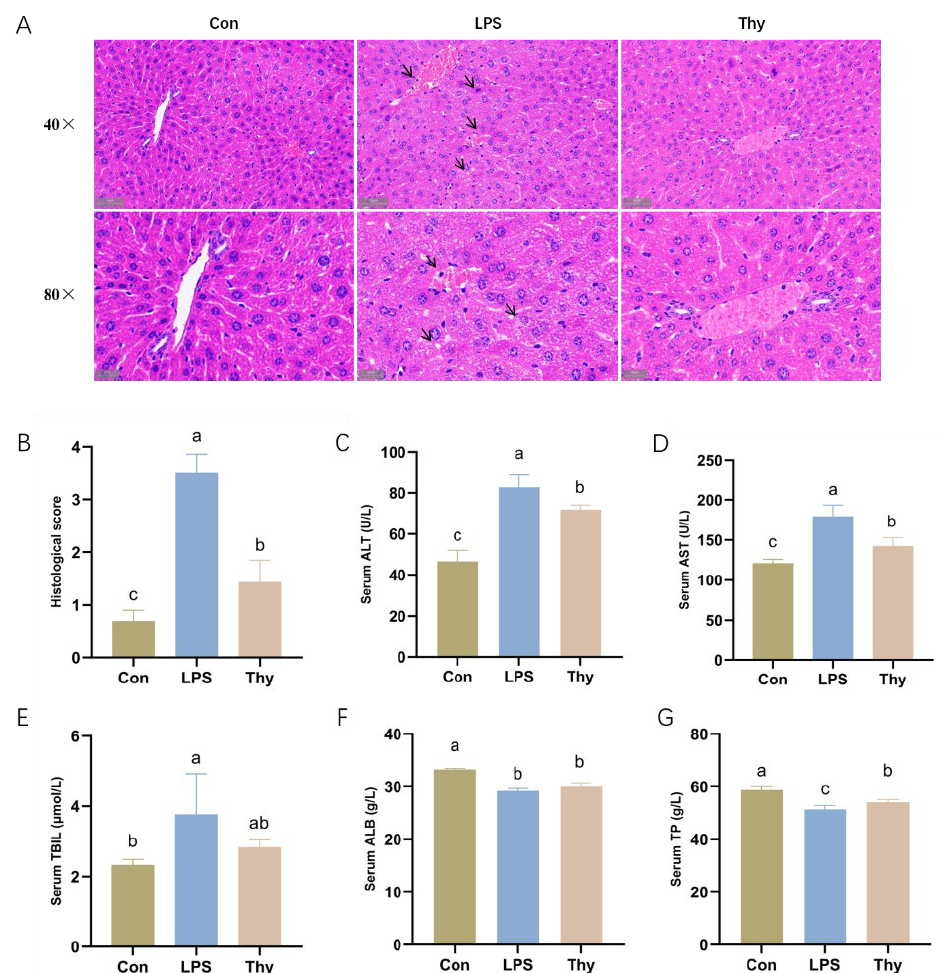
Figure 1. Thymol administration relieves liver injury induced by LPS. ( A ) Representative H&E- stained histologic sections of the liver (scale bars: 50 µ m, 20 µ m); and ( B ) analysis of the histological score. Serum levels of ( C ) ALT; ( D ) AST; ( E ) TBIL; ( F ) ALB; and ( G ) TP ( n = 3). Con, control; Thy, thymol. Differences were presented with different superscript letters ( p < 0.05).